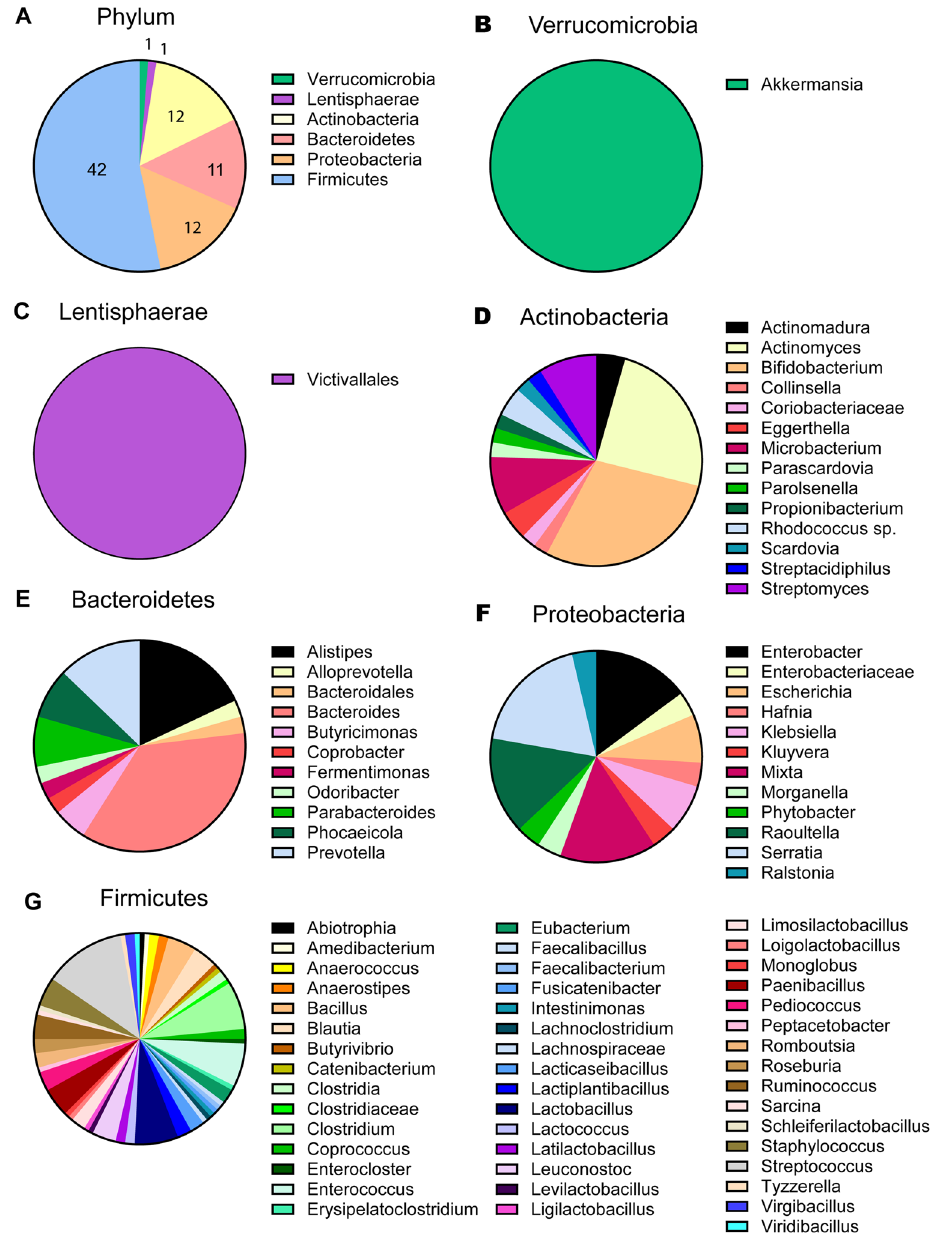
Figure 1. Human gut microbes harboring mucin associated glycosyl hydrolases (GHs) are well distributed among the bacterial phyla. ( A ) Distribution of genera within each bacteria phlya that possess mucin- related GHs. Distribution of genera within ( B ) Verrucomicrobia, ( C ) Lentisphaerae, ( D ) Actinobacteria, ( E ) Bacteroidetes, ( F ) Proteobacteria and ( G ) Firmicutes phlya that harbor at least one mucin-related